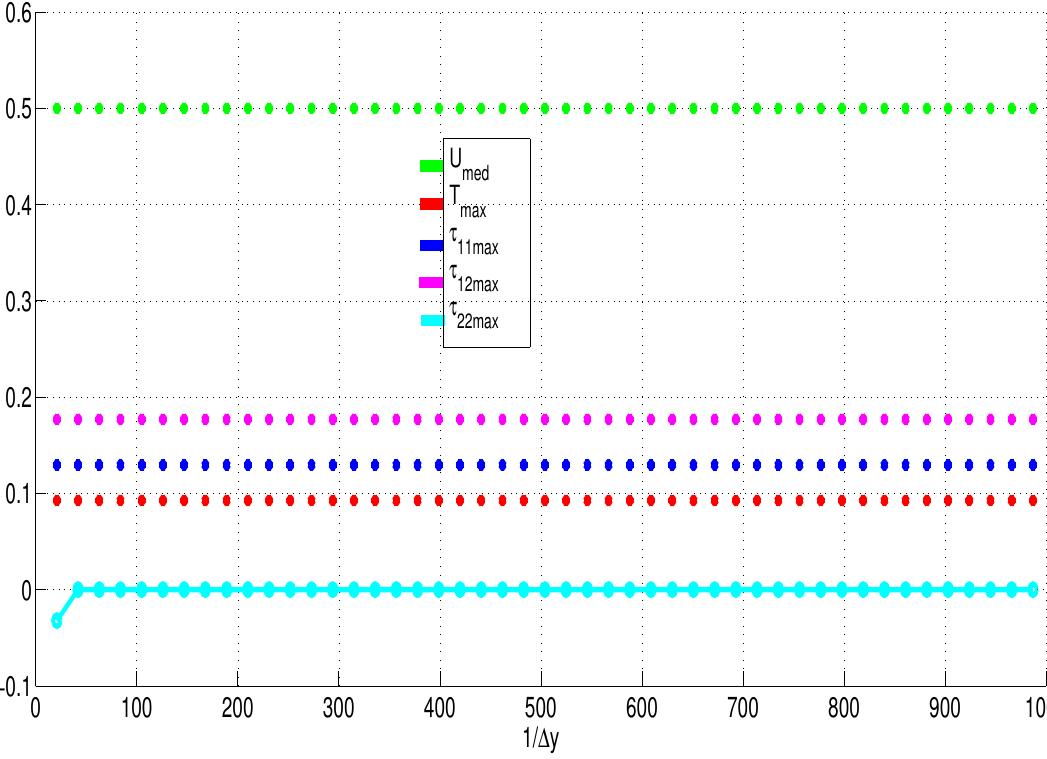
Figure 7. Dependence of solutions on